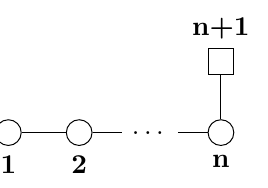
Figure 5 . The Coulomb branch of this quiver is isomorphic to the maximal nilpotent orbit of sl ( n + 1 ; C ) when the di(cid:11)erence of mass parameters